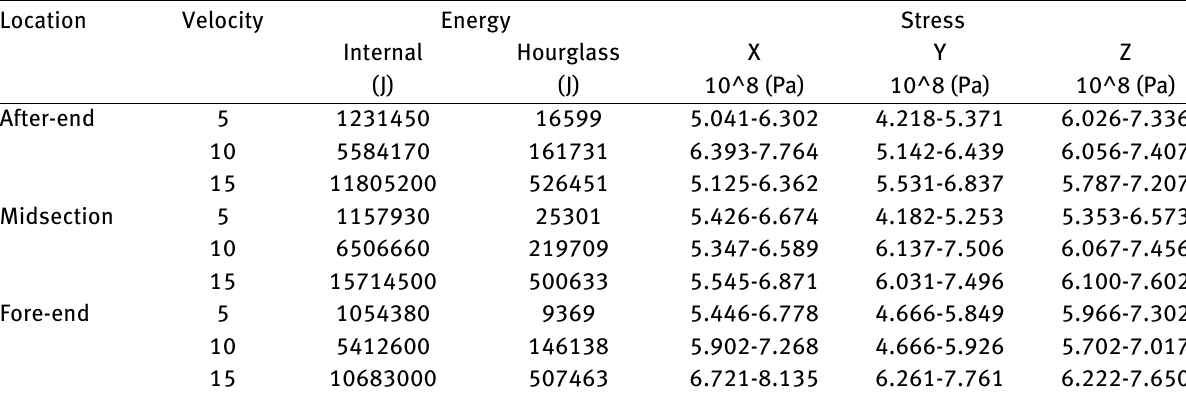
Table 1: Summary of energy and stress criteria after collision occurred on the side hull. Location